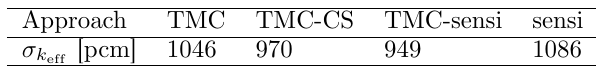
Fig. 4. Horizontal 2D map of the neutron flux in linear scale, for all energies, and separately thermal, epithermal, and fast contributions. The flux is averaged axially over 10 cm around the mid-height of the core, and the PETALE device consequently. Table 1. k eff dispersion due to 56 Fe uncertainty using 256 random cross section files.